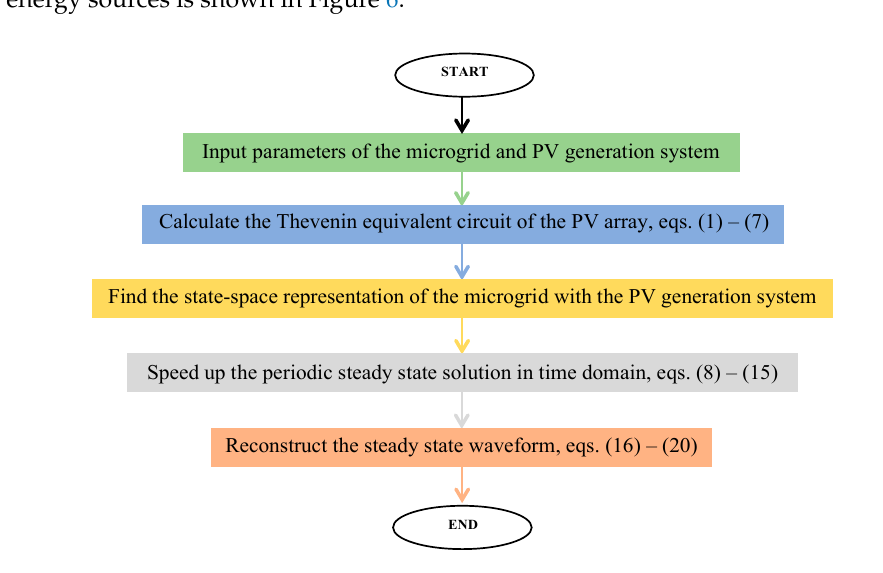
Figure 6. Flowchart of the Numerical differentiation method combined with cubic spline interpolation (ND-CSI) method.